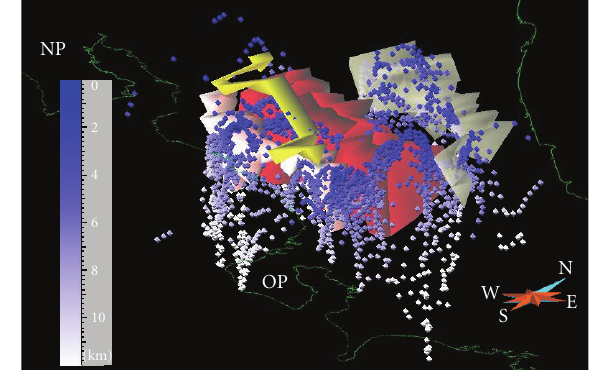
Figure 14: A second model was compiled by L¨ucke [12] and aimed to model the upper crustal density domains in the area of the active volcanic arc of Costa Rica. The structure in the center (red color) causes the gravity deficit beneath the volcanic arc. The depth-coded “points” (from blue to white) represent the source points of Euler deconvolution (Paˇsteka [51]). They are calculated independently from the gravity modeling and can help constraining the 3D model.